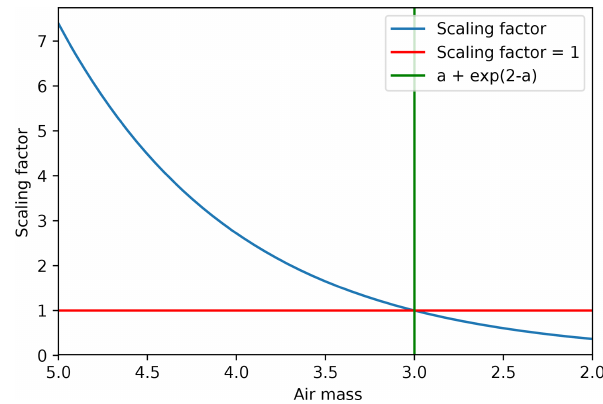
Figure 13. Scaling factor for an observation point with minimum daily air mass factor, a =